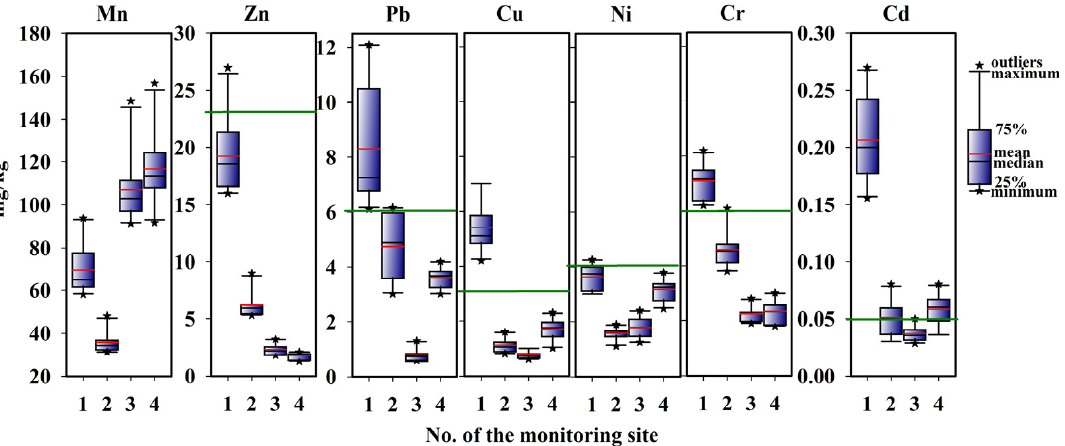
Figure 3. The concentration of HMs exchangeable forms in the soils of agricultural fields located near the power station over a 10-year monitoring period. Green line is the maximum permissible concentrations (MPC). *—outlier.